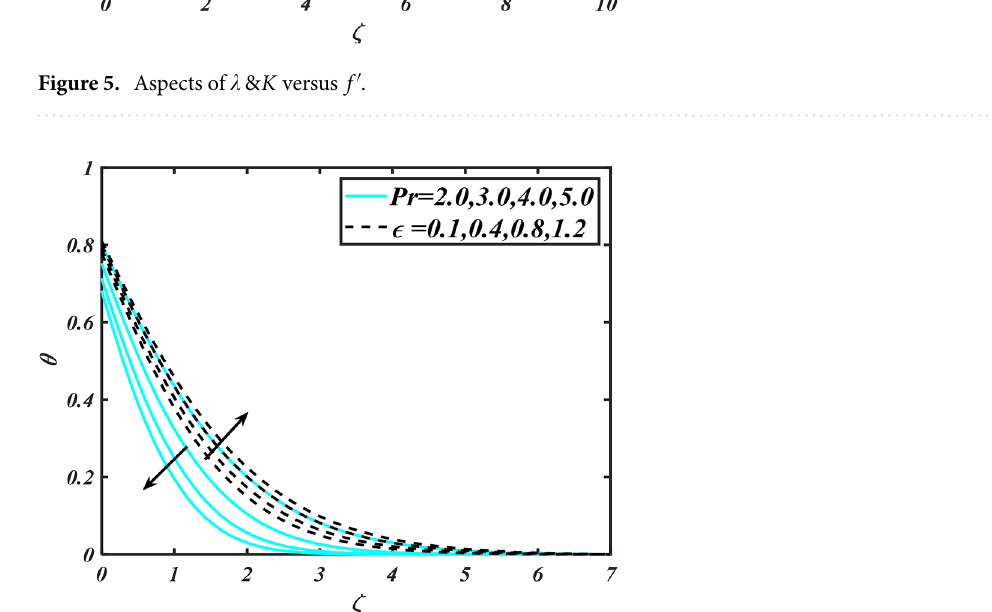
Figure 6. Aspects of Pr & ∈ versus θ